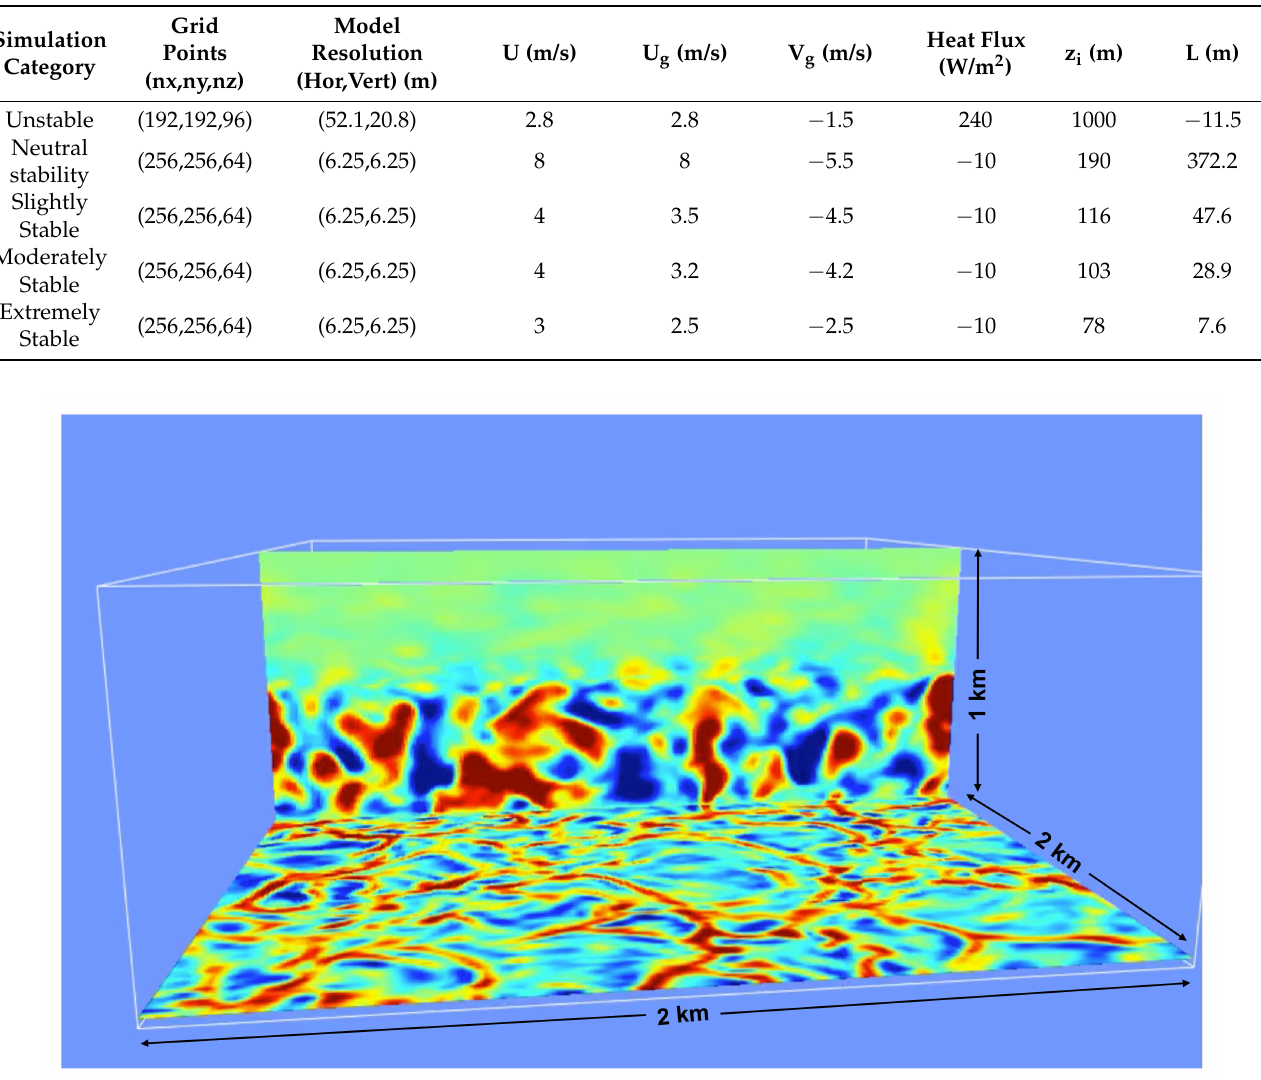
Figure 2. Illustration of a horizontal and vertical cross-section of vertical velocities for a convective planetary boundary layer (PBL) simulation. Red represents updrafts; blue represents downdrafts; and green represents areas where vertical motions are low. In this simulation, the depth of the boundary layer was set at 1000 km, clearly visible as the level where vertical velocities abruptly transition from large to small